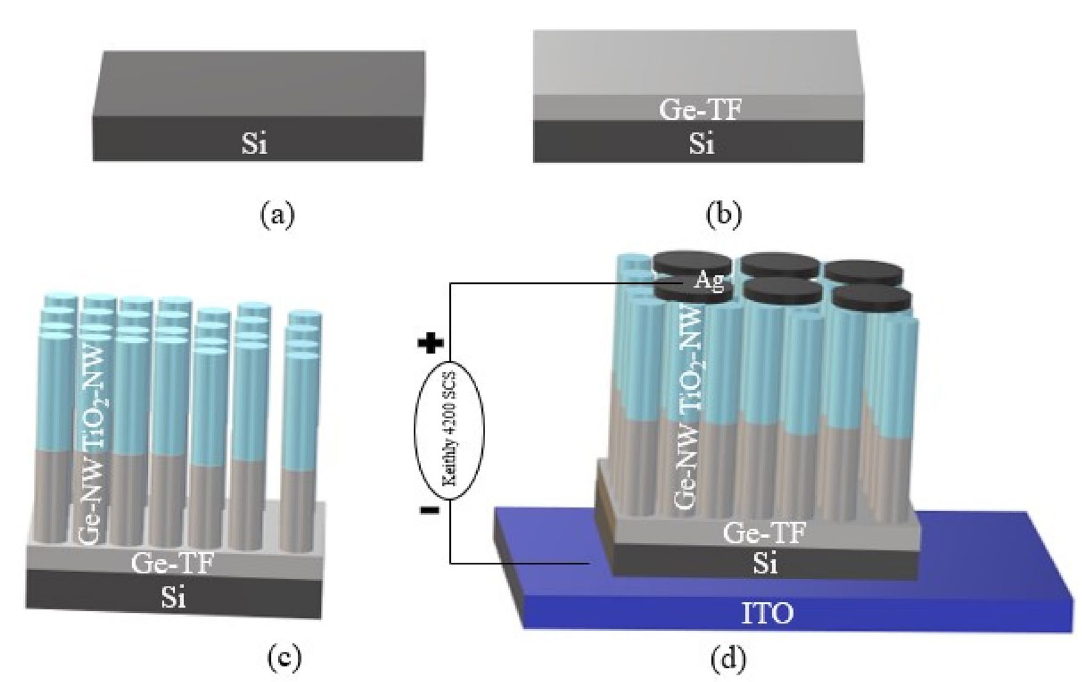
Figure 8. ( a ) Si wafer, ( b ) Synthesis of Ge-TF, ( c ) Synthesis of TiO 2 -NW/Ge-NW/Si using GLAD technique, ( d ) Synthesis of Ag/TiO 2 -NW/Ge-NW/Si (MOS) device